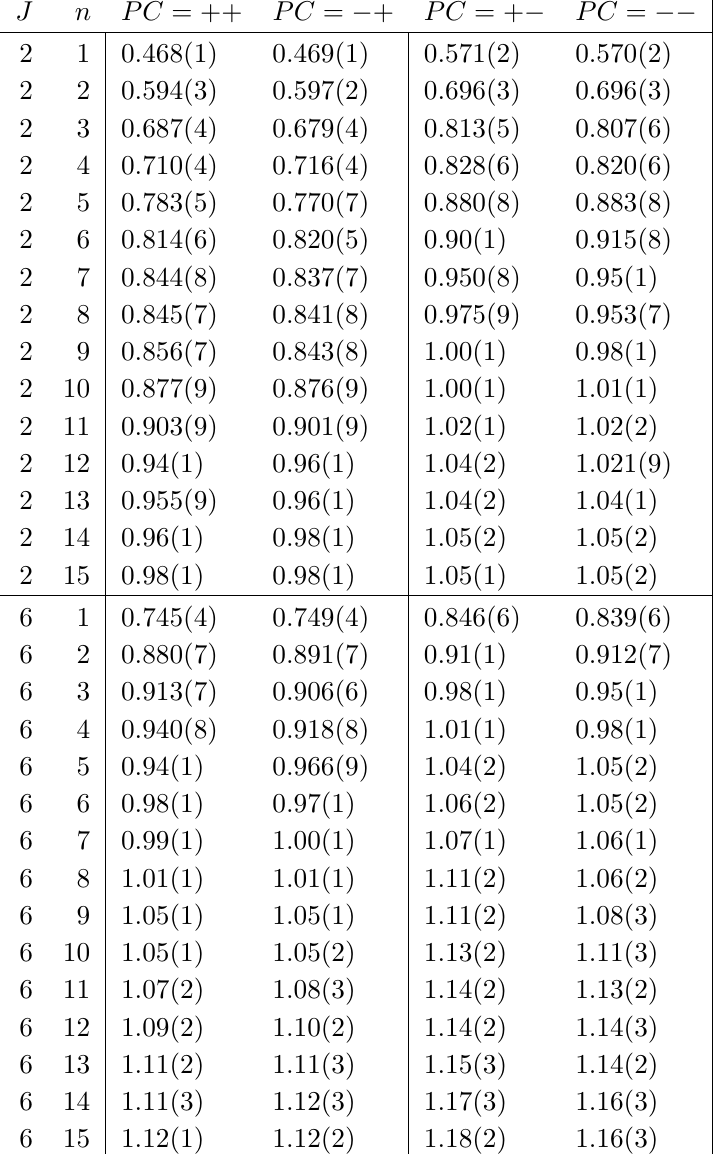
Table 6. Masses for glueballs in A 3 and A 4 representations of Z 4